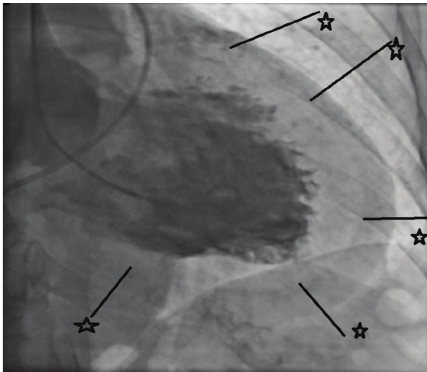
Figure 2: Pericardial tamponade with clear distinction of epicardial border ( ⋆ ) and pericardium.